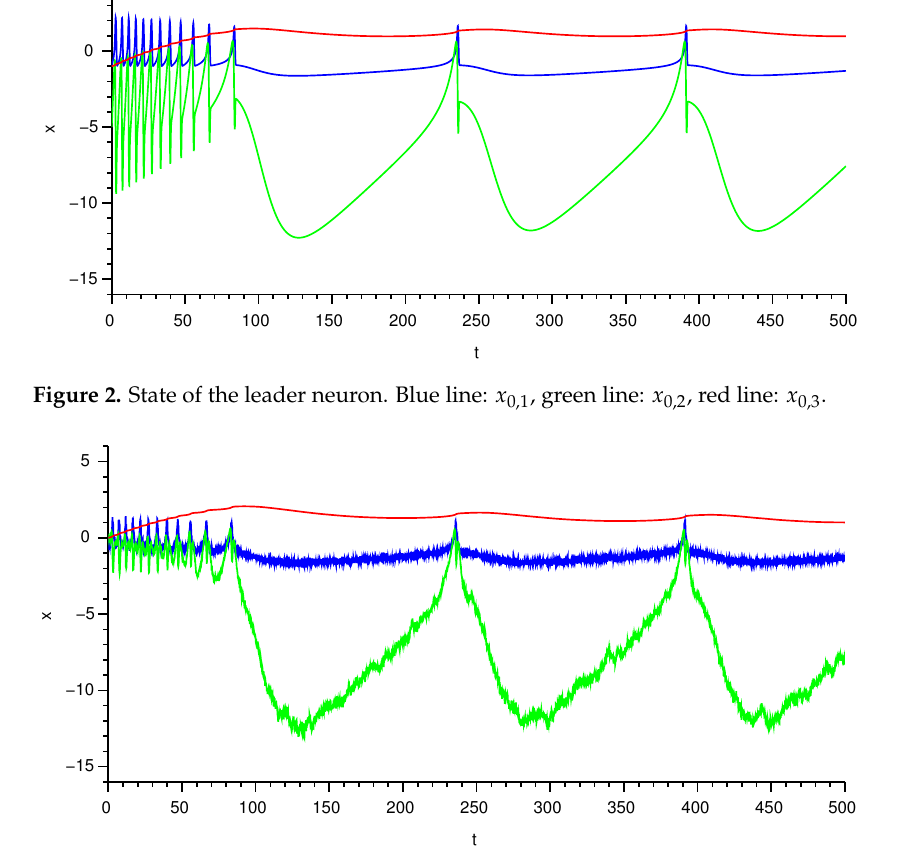
Figure 3. State of neuron 1. Blue line: x 1,1 , green line: x 1,2 , red line: x 1,3 .